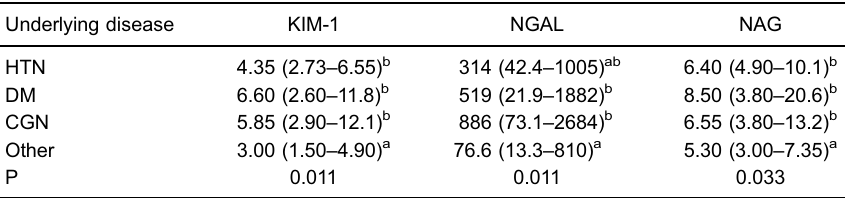
Table 5. Association between underlying disease and urinary biomarkers in patients not on dialysis at baseline. Underlying